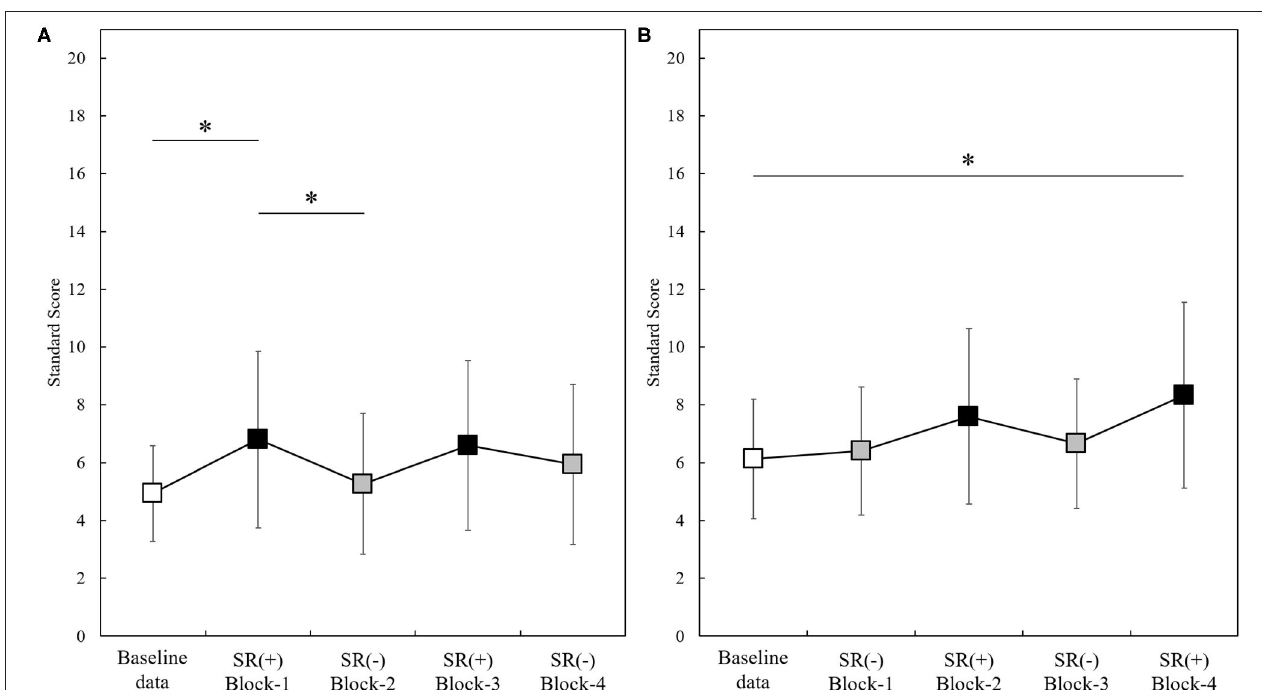
FIGURE 2 | Standard scores measured through the experiment in the two groups (Group A, N = 15; Group B, N = 15). Baseline-data (white squares); SR( + ): SR-on condition (black squares); SR(-): SR-off condition (gray squares). * p < 0.05. Panel (A) : Standard scores (mean ± standard deviation) in Group A ( N = 15). Panel (B) : Standard scores (mean ± standard deviation) in Group B ( N =